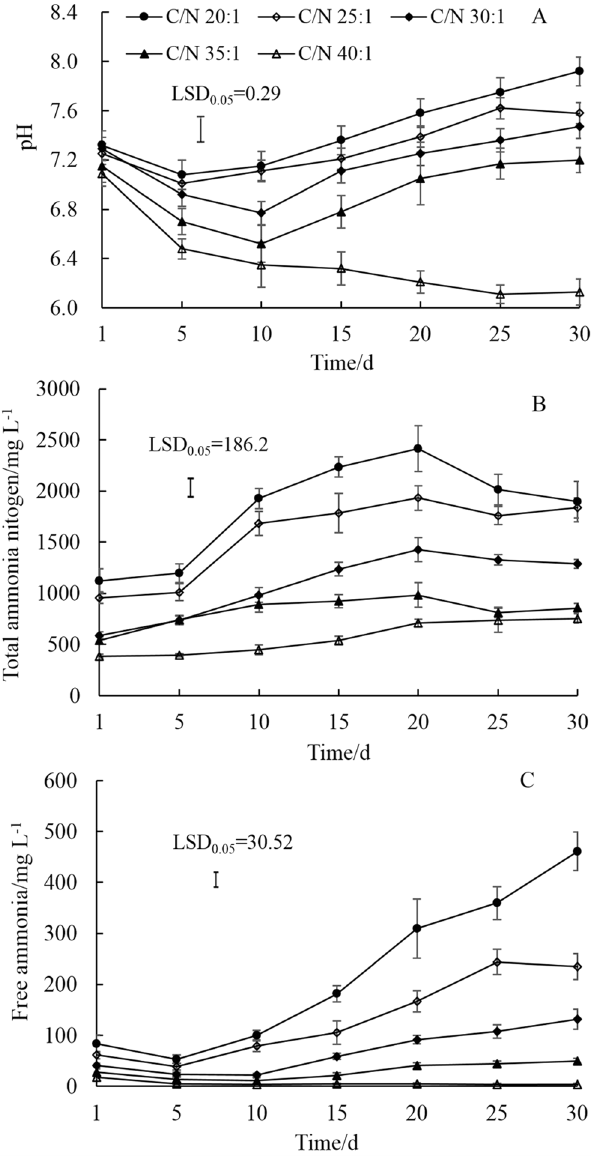
Figure 2. Changes of pH, total ammonium nitrogen, and free ammonia with different C/N ratios in the mixture of dairy manure (DM), chicken manure (CM), and rice straw (RS) in anaerobic co-digestion at 35 6 C. Values are presented as the mean 6 standard error of three replicates (n=3). Vertical bars represent LSD at the 5%